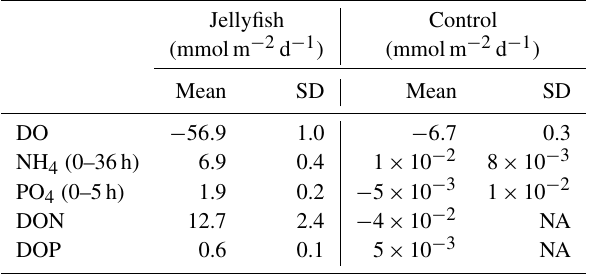
Table 2. Calculated oxygen and nutrient fluxes in the seawater of jellyfish ( R. nomadica )-enriched and control experimental cylin- ders. Positive flux represents water column enrichment (source); negative flux represents removal from the water column (sink). N = 3. SD denotes standard deviation. NA – not available. Jellyfish